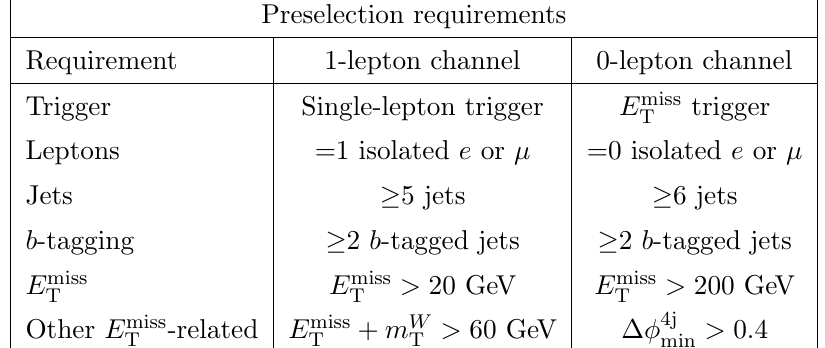
Table 1. Summary of preselection requirements for the 1-lepton and 0-lepton channels. Here m W is the transverse mass of the lepton and the E miss T separation between the E miss vector and each of the four highest- p T T